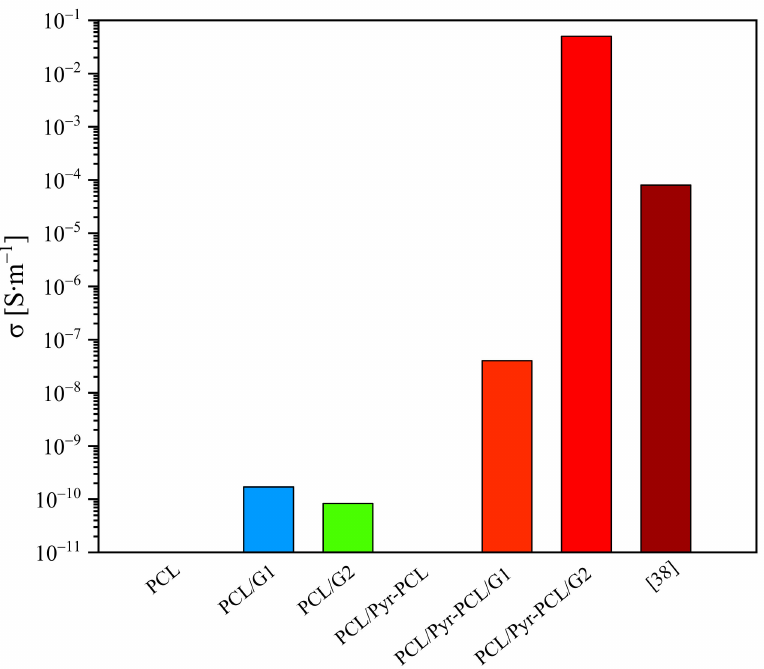
Figure 8. Surface conductivity of a commercial PCL, of our developed samples and of a PCL-based system reported in the